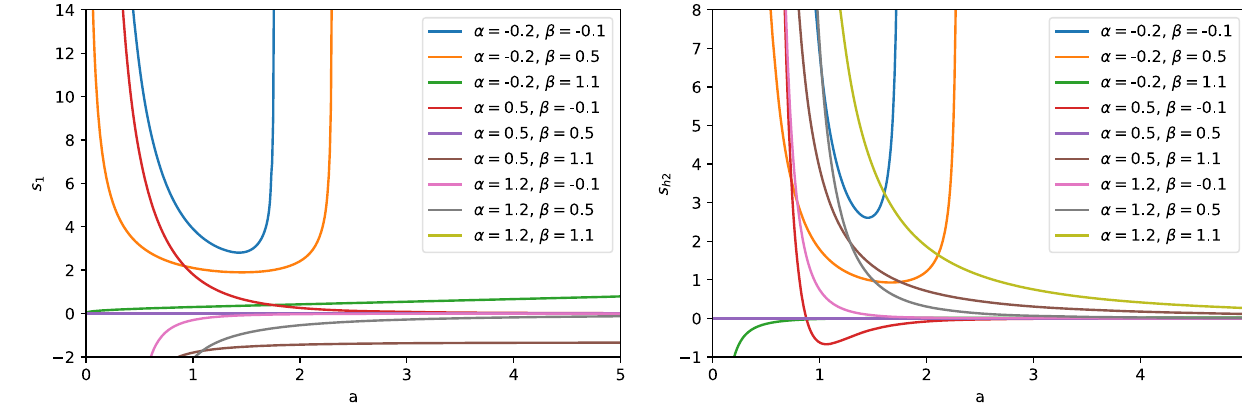
Fig. 6 Model M 5 : s 1 and s h 2 as function of scale factor for some values of (α,β)